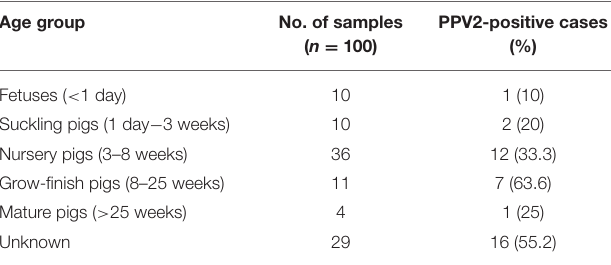
TABLE 1 | Prevalence of porcine parvovirus 2 (PPV2) detected by quantitative PCR (Ct range of 13.88–33.66; Ct median of 25.76) in different age groups. Age group No. of samples ( n =